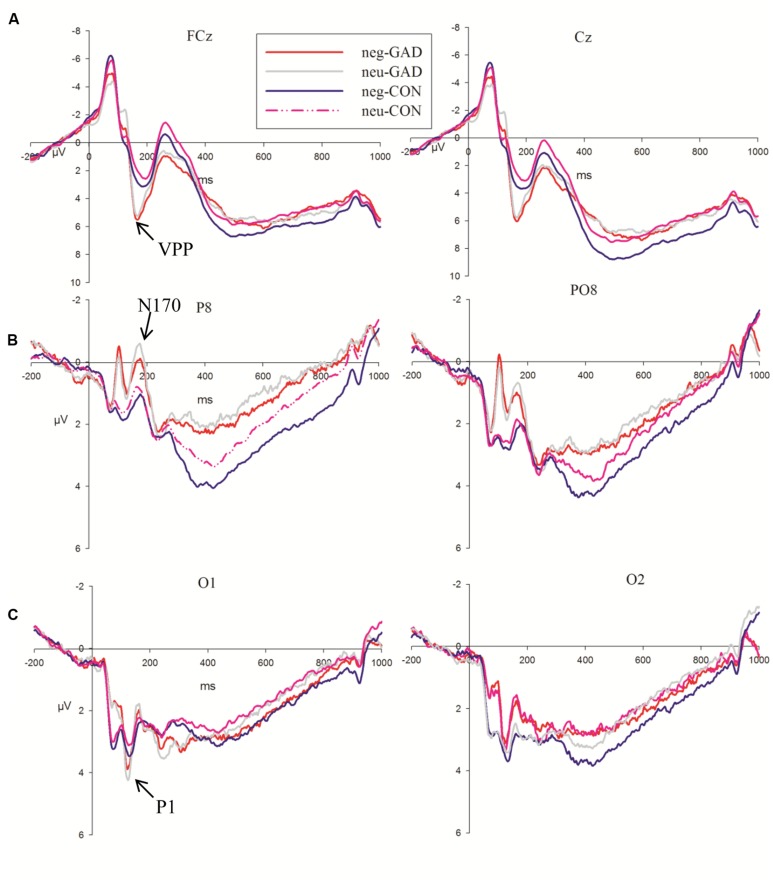
Grand averages evoked by face stimuli of the two groups at FCz, Cz, P8, PO8, O1, and O2 sites. The shaded area indicates the time windows in which the P1 (A), VPP (B), N170 (C) were analyzed (GAD, general anxiety disorder; CON, control).